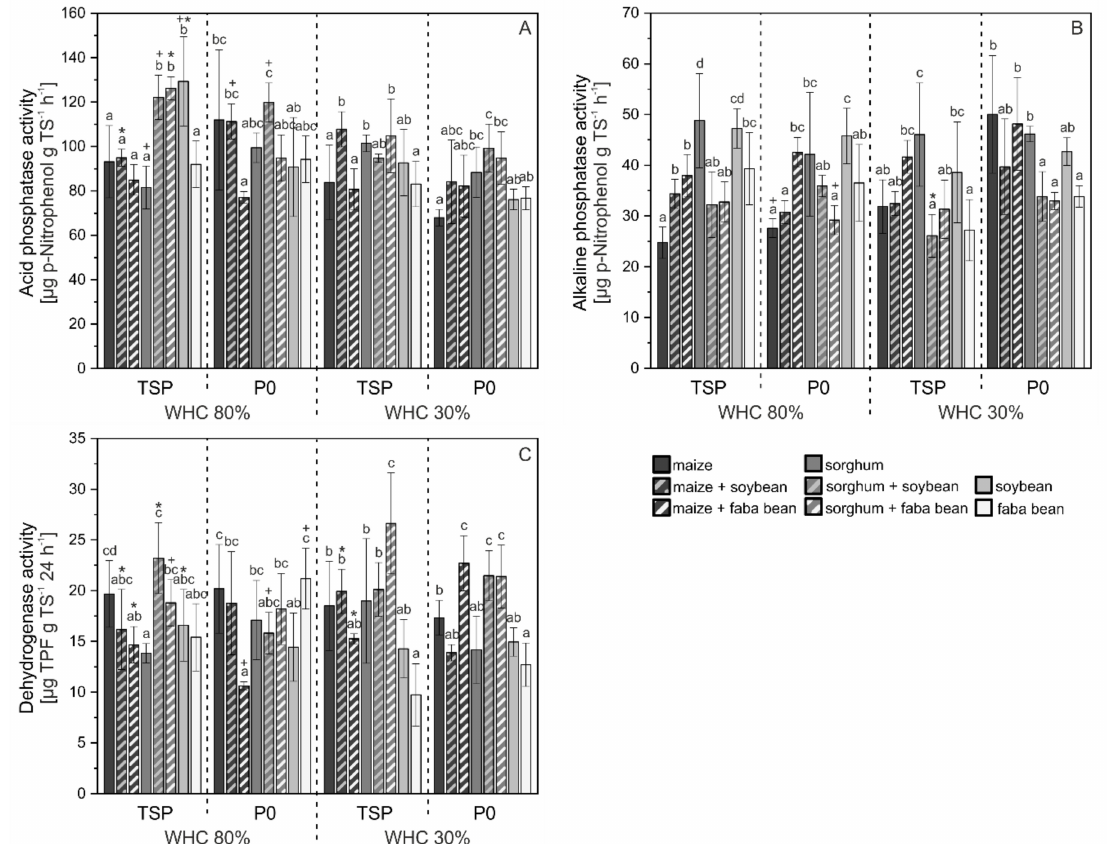
Figure 9. E ff ect of water supply, phosphorus supply and crops on the activity of acid ( A ) and alkaline phosphatase ( B ) and dehydrogenase ( C ) in soil after crop harvest in the Water-P-Trial (mean ± SD). Di ff erent letters indicate significant di ff erences between the crop variants at each water and P level, + indicates di ff erences between the water levels, * indicates di ff erences between the P levels (ANOVA and Duncan’s test, p ≤ 0.05). WHC = water holding capacity, TSP = triple-super P, P0 = control without